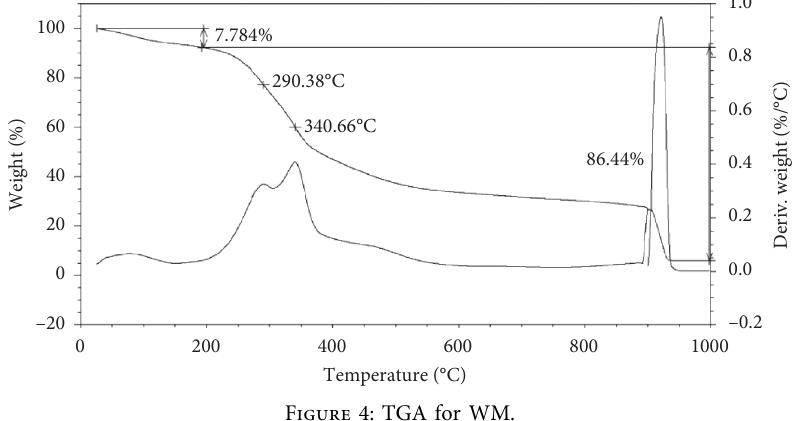
Figure 4: TGA for WM.